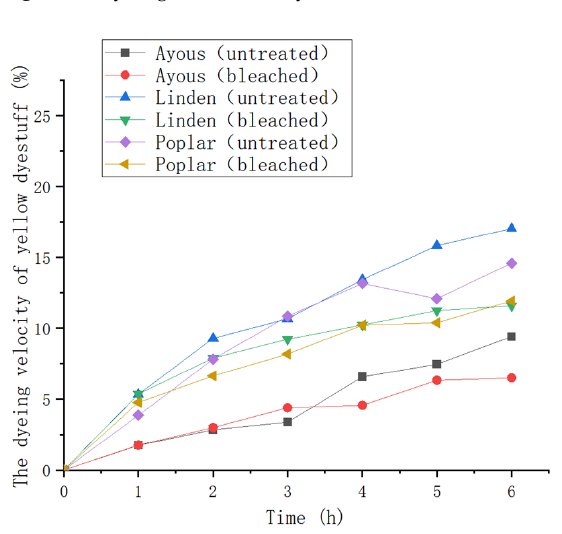
Figure 6. Dyeing rate of yellow dyestuff.